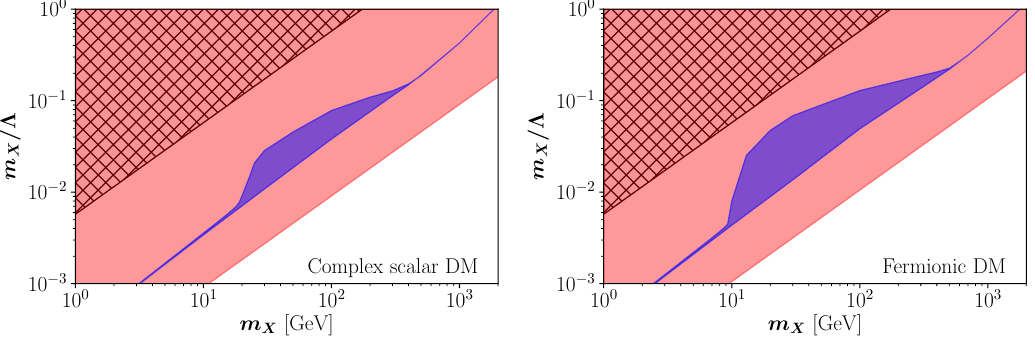
(cid:30) 1 jj computed in our UV model as function ! !